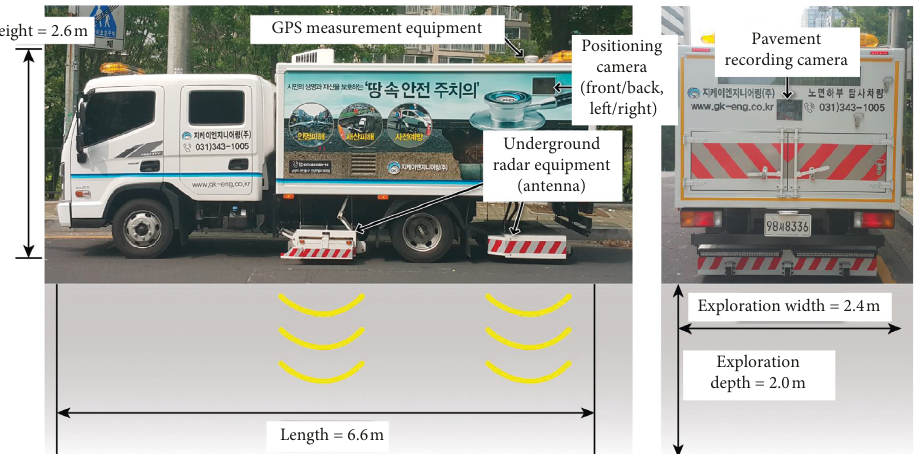
Figure 2: Extended multichannel GPR exploration equipment mounted on a